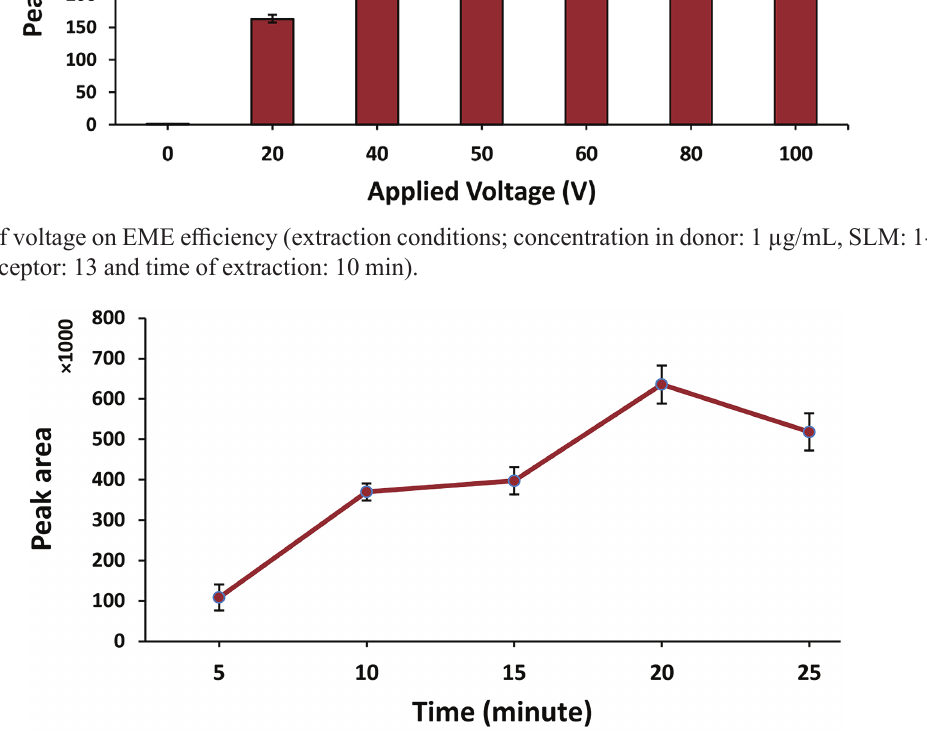
FIGURE 5 - Effect of extraction time on EME efficiency (extraction conditions; concentration in donor: 1 µg/mL, SLM: 1-octanol, pH of donor: 9.0, pH of acceptor: 13 and voltage: 40